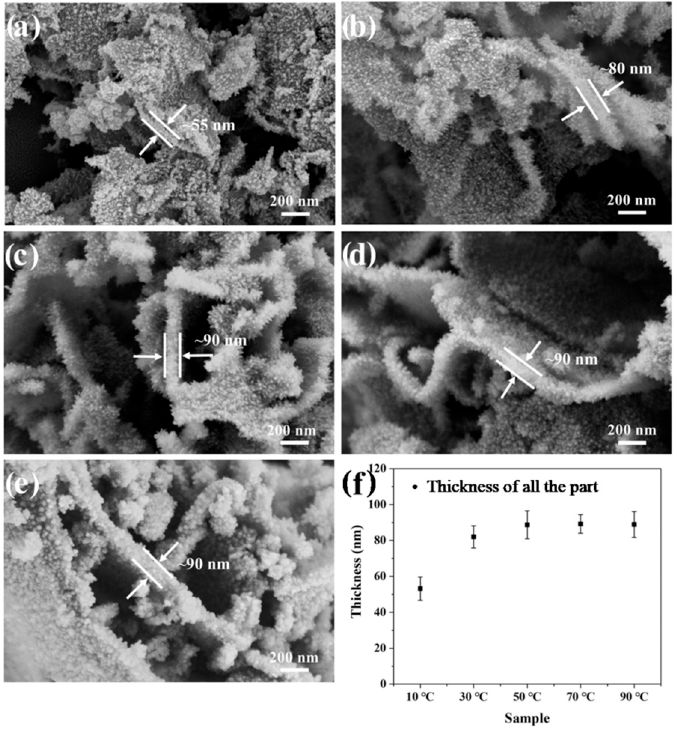
Figure 7. Typical SEM images of the samples with different synthesis temperatures: ( a ) 10 °C, ( b ) 30 °C, ( c ) 50 °C, ( d ) 70 °C and ( e ) 90 °C. ( f ) The thickness data of the samples.